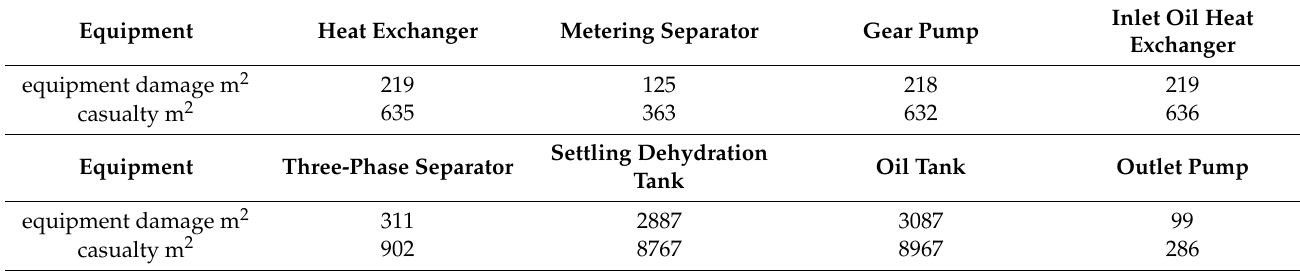
Table 11. Impact area of comprehensive accident